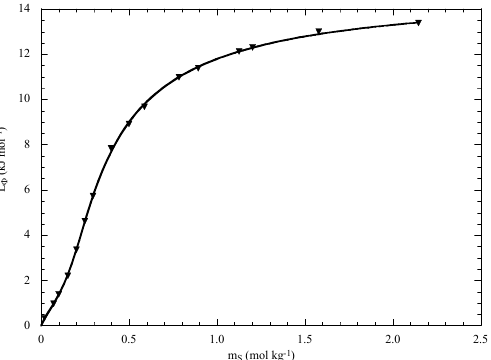
Figure 3. Apparent molar relative enthalpies of N,N,N -octylpentyldimethylammonium chloride in water as functions of the surfactant concentration at 298 K. The line is the best fit according to Eqs. 10-12. Data are from Ref.